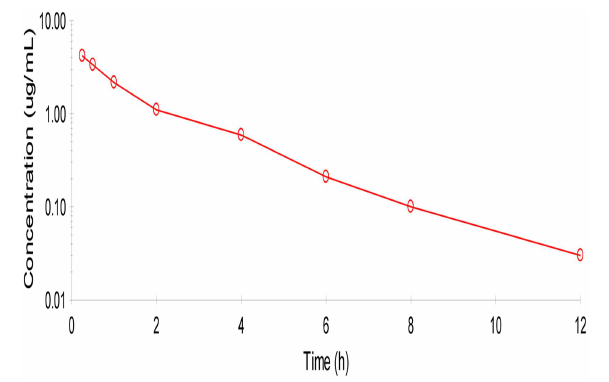
FIGURE 1 | Semi-logarithmic plot of mean serum concentration after intra venous administration of cefquinome (1mg/kg) in cattle ( n = 6 ). Two compartment method (Winonlin software) were used to observe the concentration-time